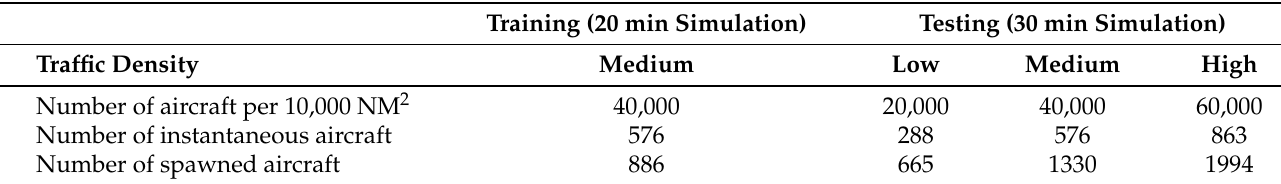
Table 4. Traffic volume used in the experimental